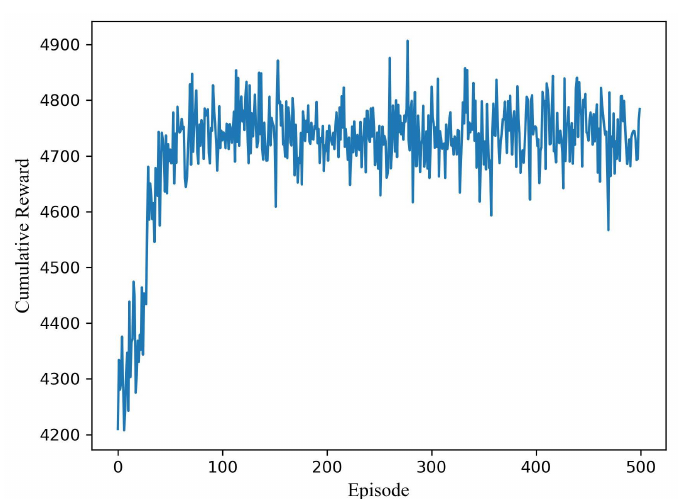
Figure 3. Optimization process for a pair of users under dynamic channel and hierarchical